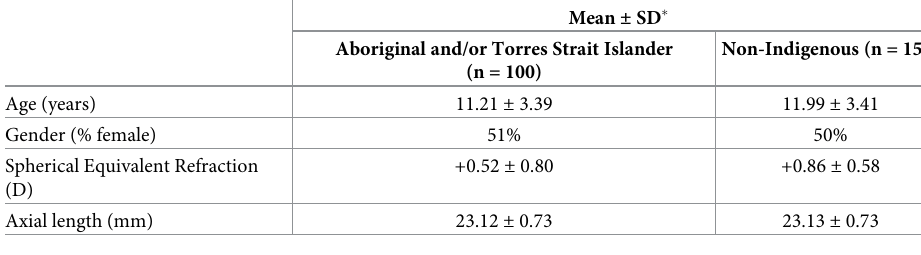
Table 1. Demographic information and ocular biometric measures of the Aboriginal and/or Torres Strait Islander children and non-Indigenous children.